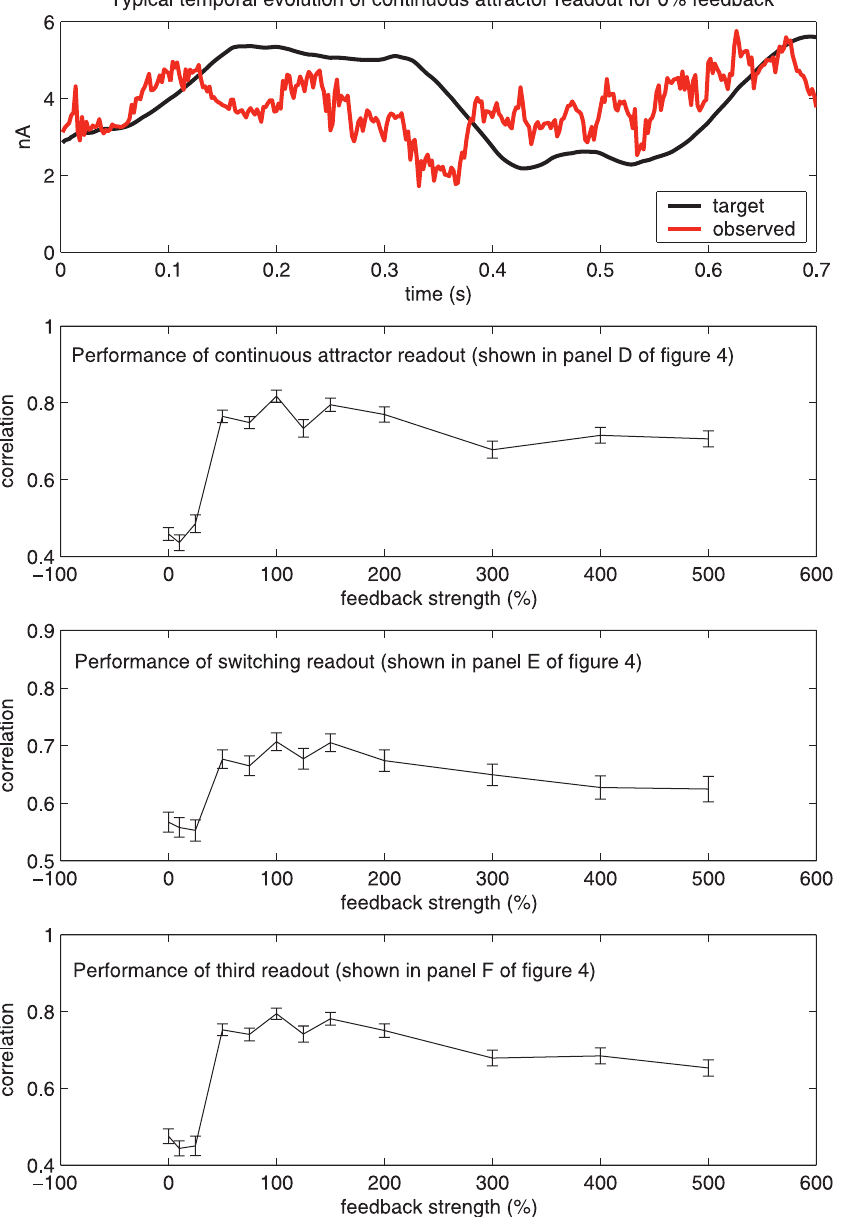
Figure 7. Evaluation of the Dependence of the Performance of the Circuit in Figure 4 on the Feedback Strength (i.e., on the Mean Amplitude of Current Injection from the Readout Back into Neurons in the Circuit) For each feedback strength that was evaluated, the readouts were trained and tested for this feedback strength as for the preceding experiments. Error bars in (B–D) denote standard error. These control experiments show that the feedback is essential for the performance of the